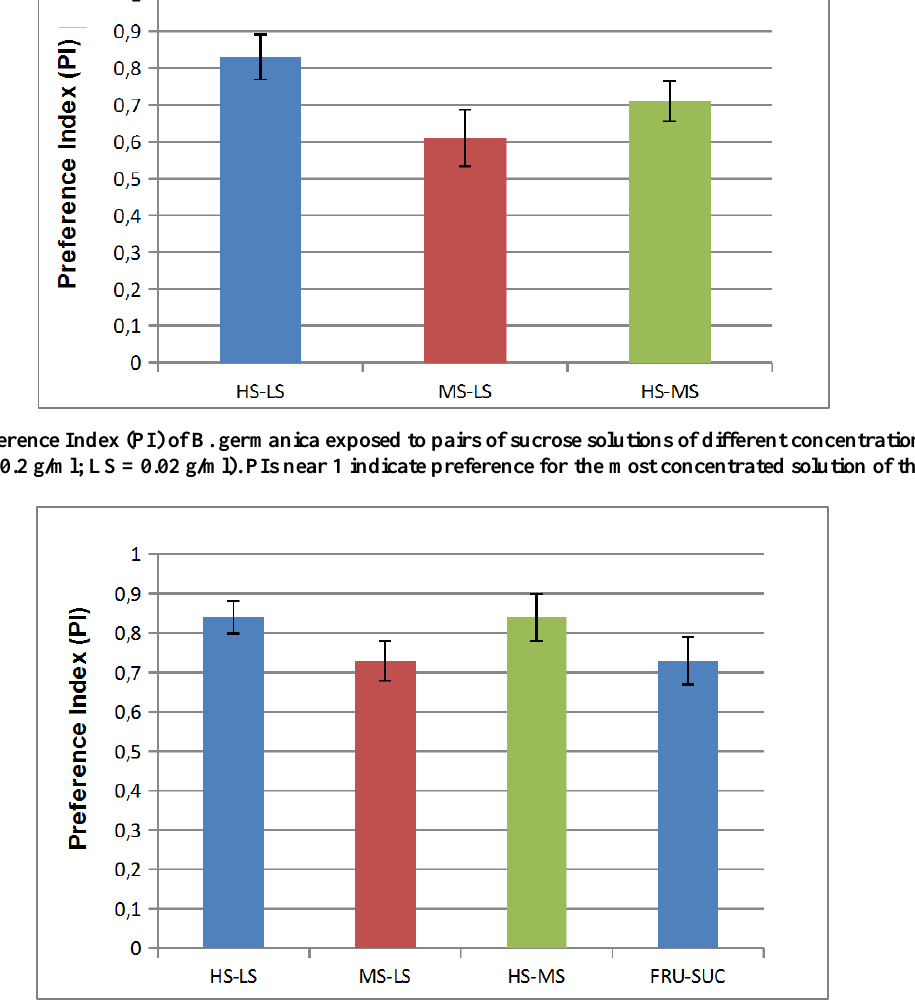
(p < 0.05, Kruskall-Wallis and Dunn´s test; Figure 5a). Conversely, the number of visits and the weight gain